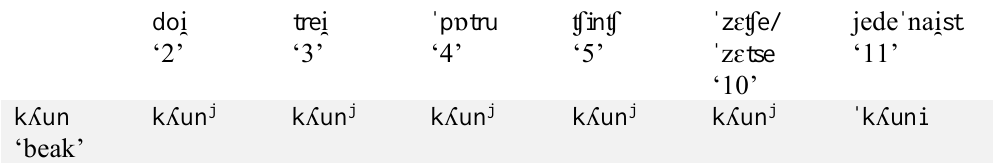
Table 18. Marking of the ‘eleven’ threshold by - i in masculines